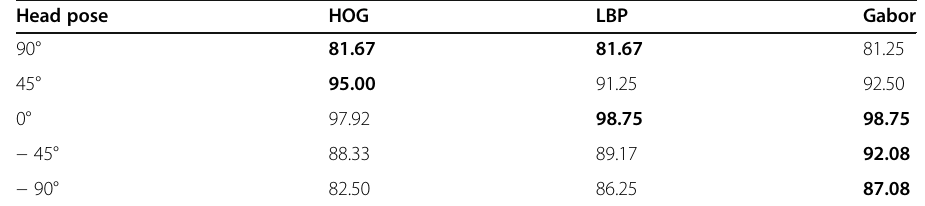
Table 3 Recognition rates (%) for person-independent facial expression recognition. The best recognition rates are highlighted in bold